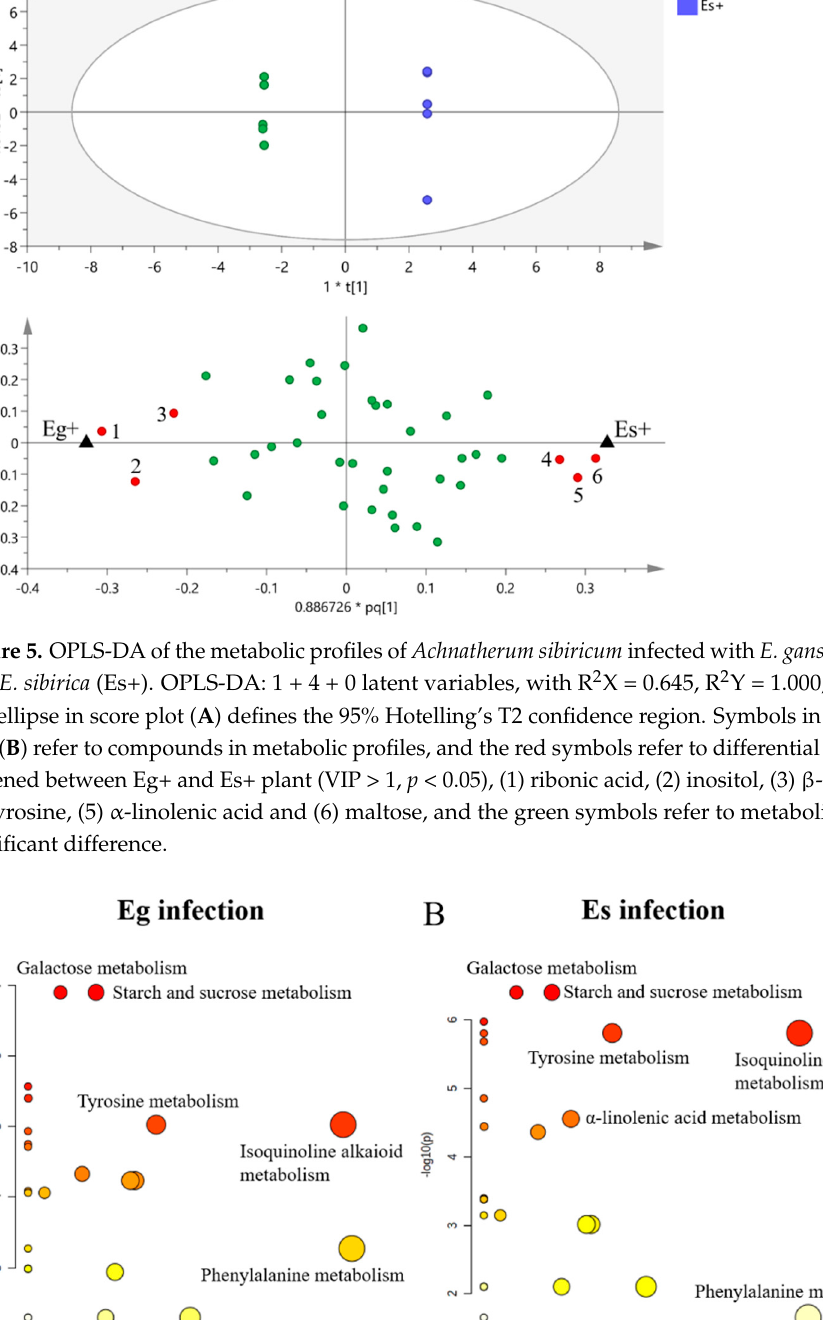
with R 2 X = 0.648, R 2 Y = 0.998, Q 2 = 0.843. The ellipse in score plot (A) defines the 95% Hotelling’s T2 confidence region. Symbols in the loading plot ( B ) refer to compounds in metabolic profiles, and the red symbols refer to differential metabolites screened between E − , Eg+ and Es+ plant (VIP > 1, p < 0.05), (1) mannitol, (2) sucrose, (3) threonic acid, (4) allose, (5) fructose, (6) glucose, (7) α -tocopherol, (8) tyrosine, (9) α -linolenic acid, (10) maltose, (11) phenylalanine, (12) glycine, (13) valine, (14) ornithine and (15) octadecanoic acid, and the green symbols refer to metabolites with no significant difference.